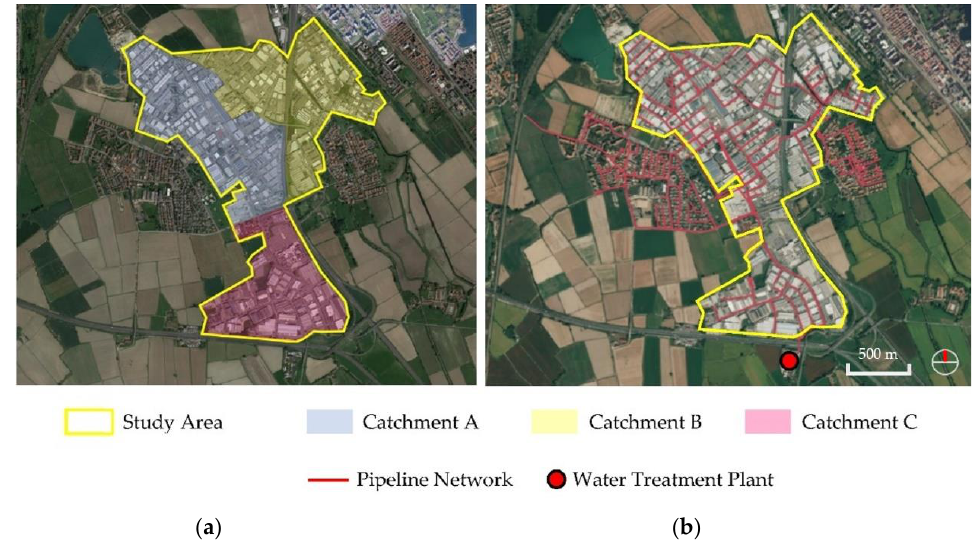
Figure 1. Identification of the case study area with its subdivision into three macro-catchments ( a ) and drainage network ( b ).